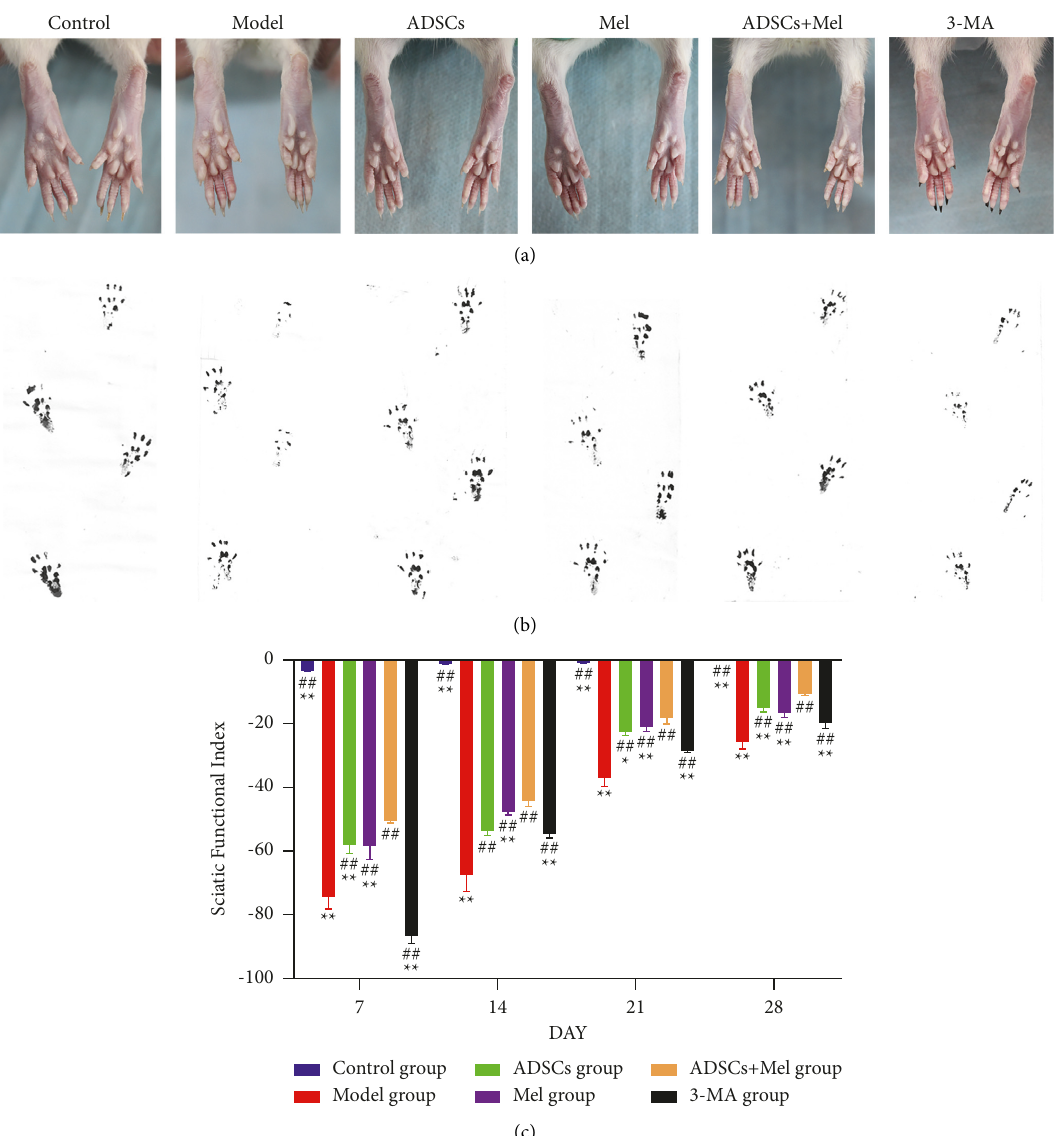
Figure 5: Effects of ADSCs combined with Mel on functional recovery. (a) Recovery of foot morphology. (b) Rat footprint. (c) SFI scores for the functional recovery at different time points. The control group, ADSCs group, Mel group, ADSCs+Mel group, and 3-MA group were compared with the model group, respectively. Each value is the mean ± SE of five independent determinations. ## P < 0 . 01 and # p < 0 . 05, compared with the model group; ∗∗ p < 0 . 05, the control group, ADSCs group, model group, Mel group, ADSCs+Mel group, and 3-MA group were compared with the ADSCs+Mel